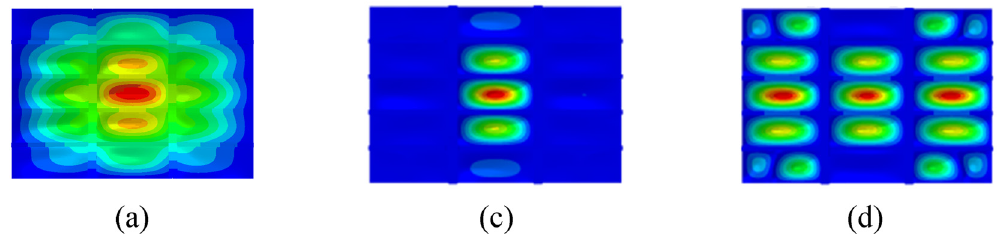
Figure 14: Vibration velocity response diagram of two - point excitation: ( a ) 53 Hz, ( b ) 97 Hz, and ( c ) 103 Hz.